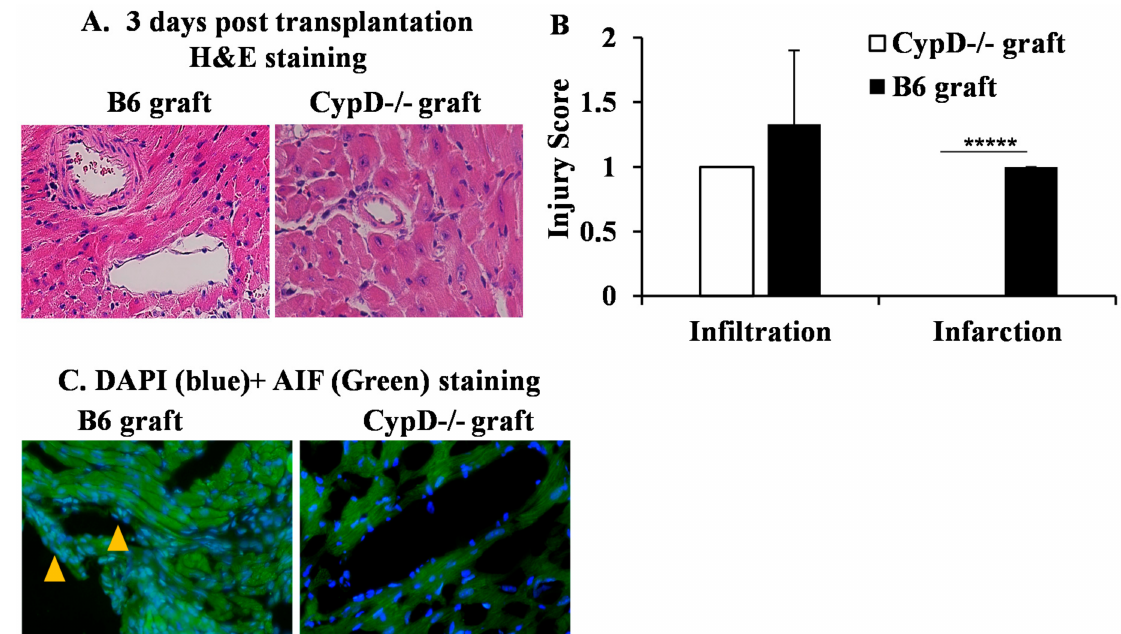
Figure 6. CypD deficiency in a donor graft attenuates IRI and AIF translocation. Cardiac grafts from wild-type and CypD − / − B6 mice were subjected to ischemic storage at 4 ◦ C for 4 h before being transplanted into BALB/c mice. Three days after, grafts were collected for H&E and AIF staining. ( A ) Pictures were taken at 200 times magnification and representative of 4 grafts in each group. ( B ) Graft injuries were scored in a blinded fashion and averaged from 4 grafts. ***** p ≤ 0.00001. Student’s t -test. ( C ) Graft sections were stained with anti-AIF-PE and DAPI. Pictures were taken at 200 times magnification. Colocalization of AIF and DAPI is indicated by arrows. Representative images are